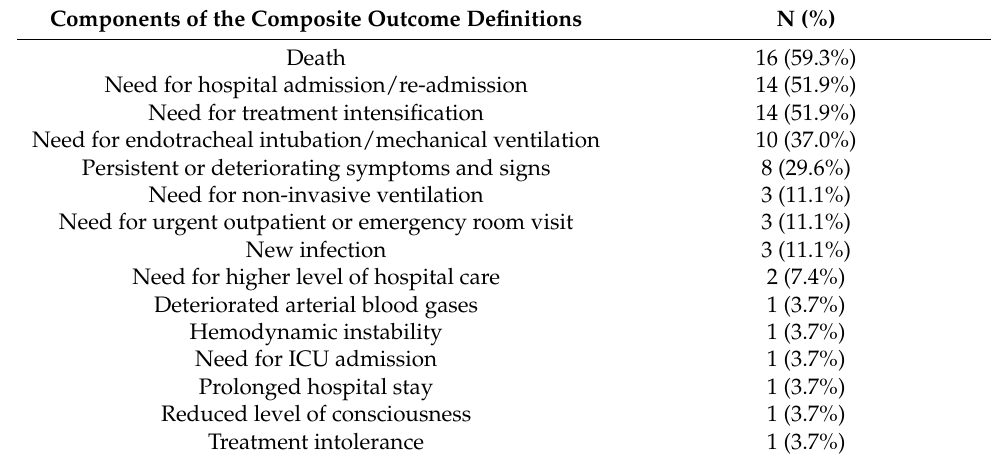
Table 3. Undesirable outcomes included in the composite treatment failure instruments, along with the frequency in which they were utilised.